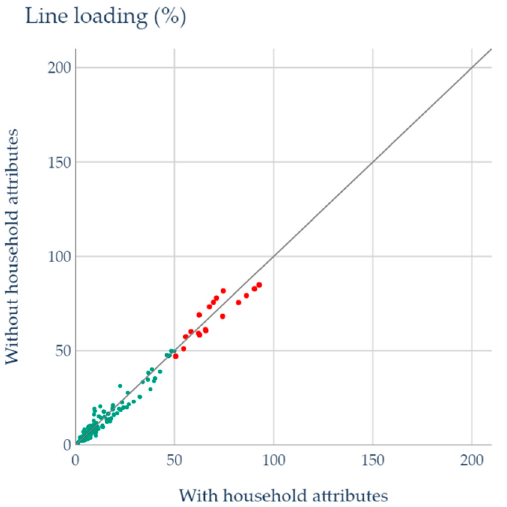
Figure 11. Comparison of median line loadings based on charging point allocations with and without consideration of household attributes. 50 spatial allocation variants.